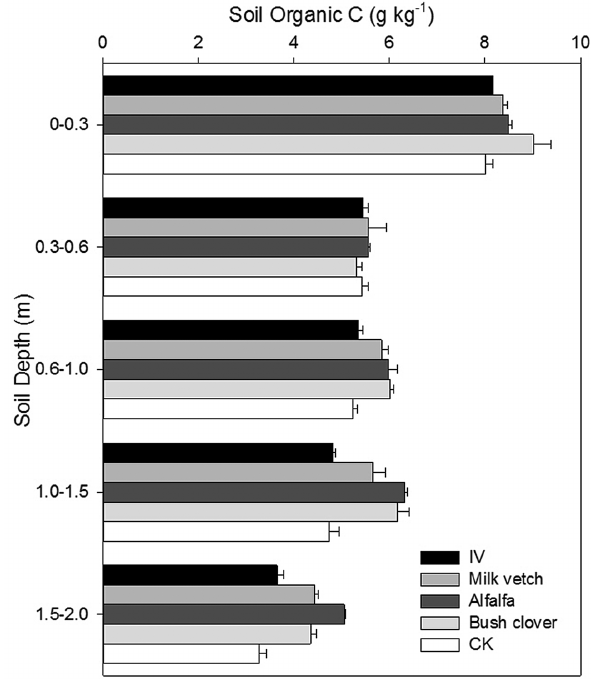
Figure 2. Concentration of soil organic carbon (SOC) with depth in May 2004 (IV) and in October 2010 under three forage legumes: milk vetch, alfalfa and bush clover, and bare soil (CK). Bars give + one standard error of the mean ( n =